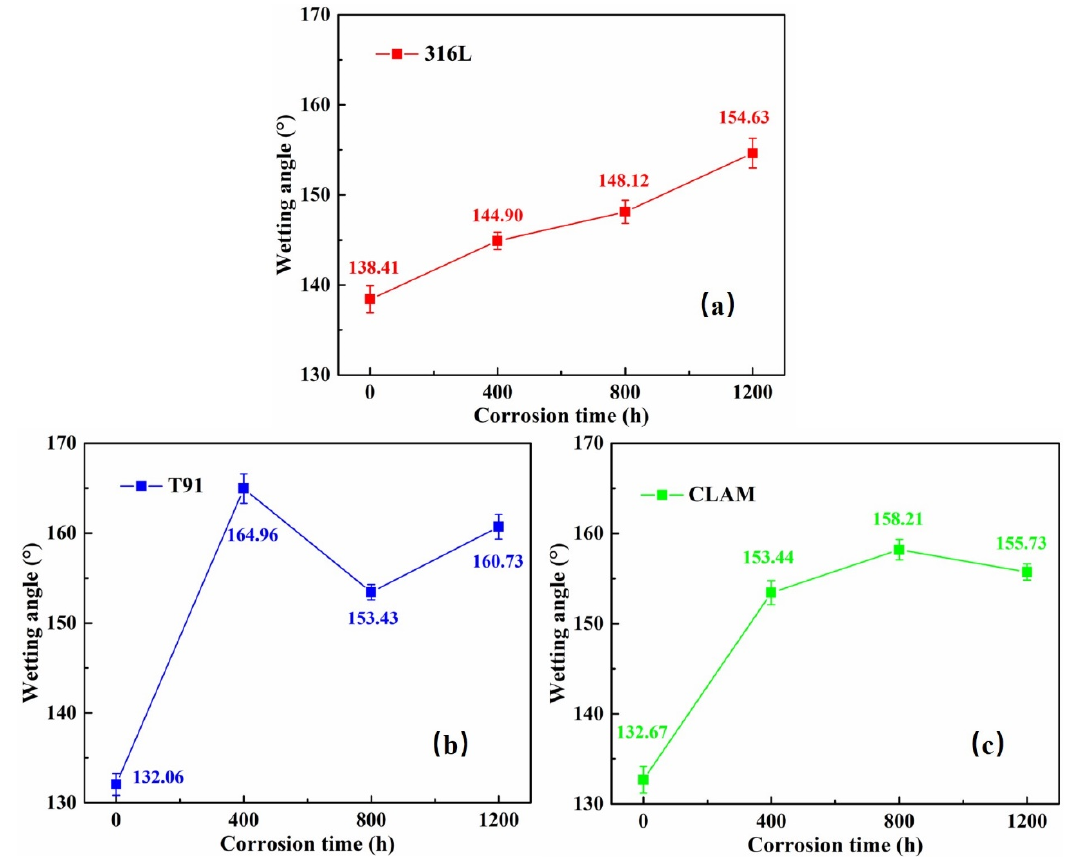
Figure 5. The statistical wetting angles of samples before and after corrosion at 450 °C: ( a ) 316L, ( b ) T91, ( c ) CLAM. ( b ) T91, ( c )